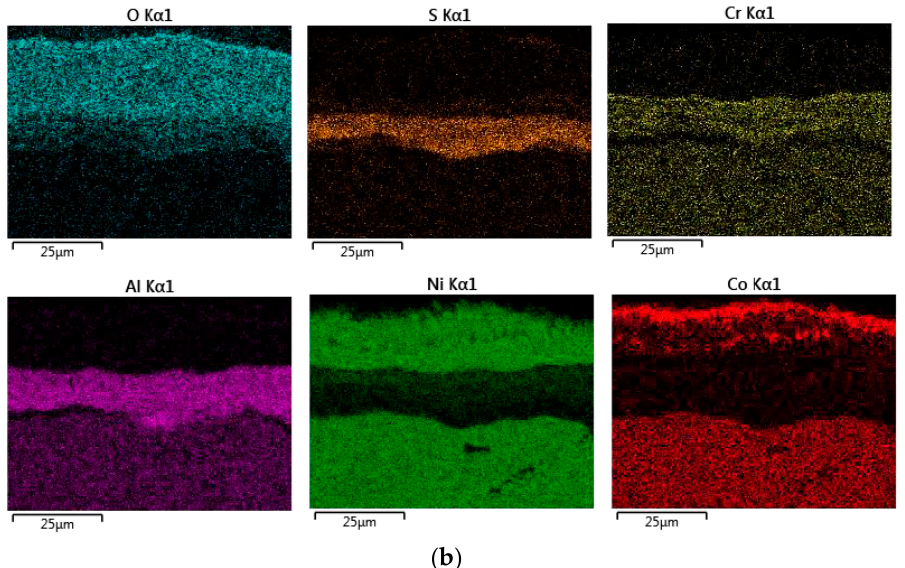
Figure 7. Cross-section of Rene ′ N5 sample corrosion layers after 300 h LTHC at 700 °C. ( a ) Secondary electron (SE) image showing two primary layers and internal carbides. ( b ) Elemental rasters for O, S, Cr, Al, Ni, Co showing inner Cr, Al, S bands and outer Ni, Co bands.